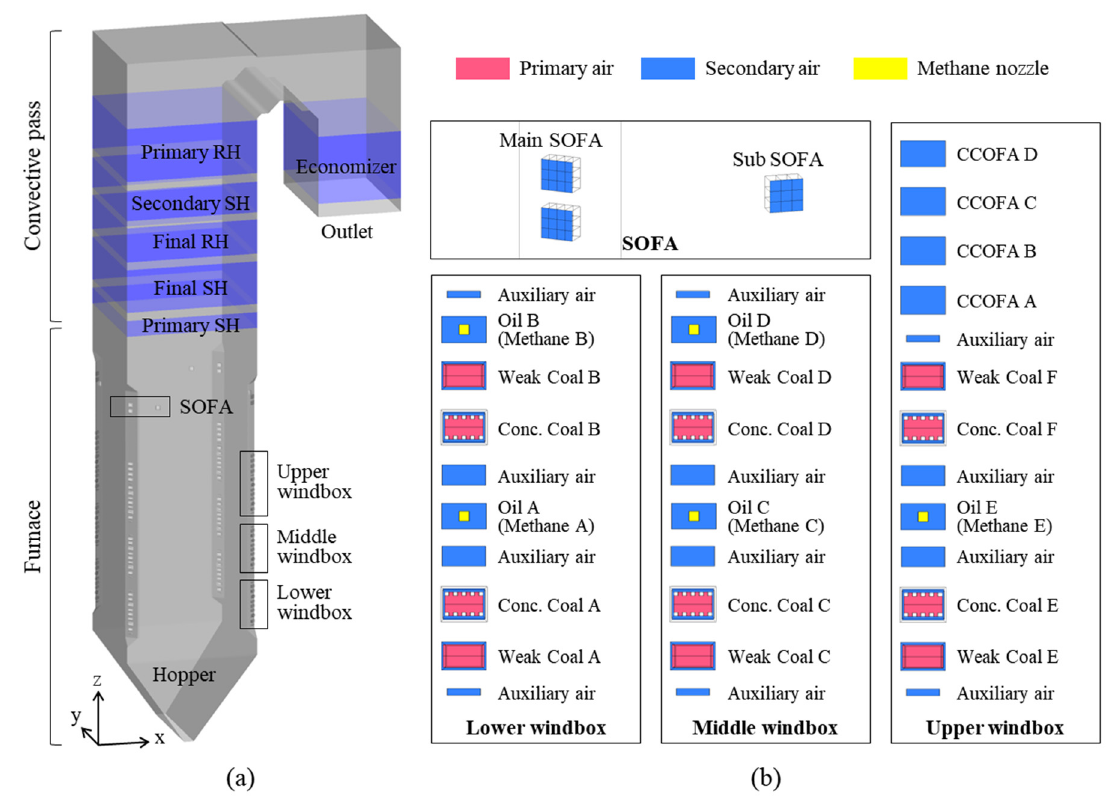
Figure 1. ( a ) Boiler geometry and ( b ) burner arrangement with methane nozzles. Conc.: concentrated; CCOFA: close-coupled overfire air; SOFA: separated overfire air; SH: superheater; RH: reheater.